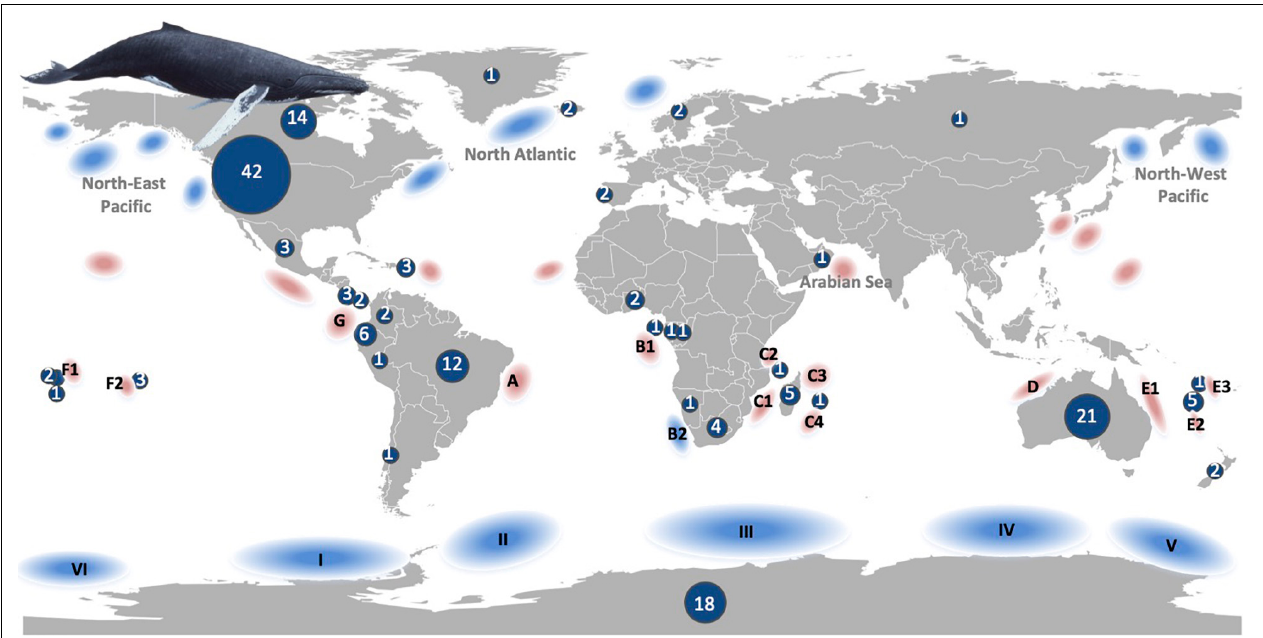
FIGURE 3 | Humpback whale populations (at least 16 distinct populations shown as combined North-East Pacific, North Atlantic, Arabian Sea, North-West Pacific for the Northern Hemisphere and A-G breeding populations for the Southern Hemisphere) with approximate breeding (red) and feeding (blue) areas (classification based on Jackson et al., 2015). The number of studies extracted from 148 publications that investigated environmental drivers and humpback whale distribution are shown by country and separately for Antarctica.